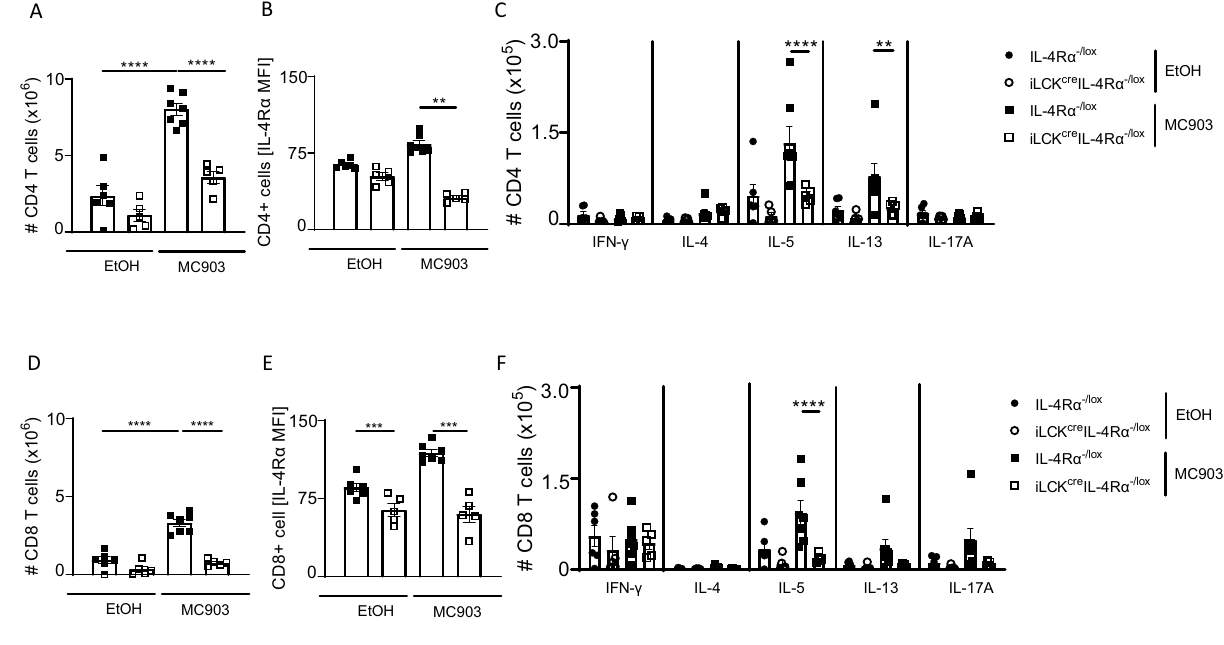
Figure 3. Pan T cell IL-4R ⍺ responsiveness is essential in acute MC903-induced atopic dermatitis. ( A ) CD4 T cell numbers in inguinal lymph nodes in IL-4R ⍺ −/lox littermate and iLCK cre IL-4R ⍺ −/lox treated with EtOH and MC903. ( B ) IL-4R ⍺ expression in CD4 T cells. ( C ) CD4 T cell cytokine production (IFN-γ, IL-4, IL-5,